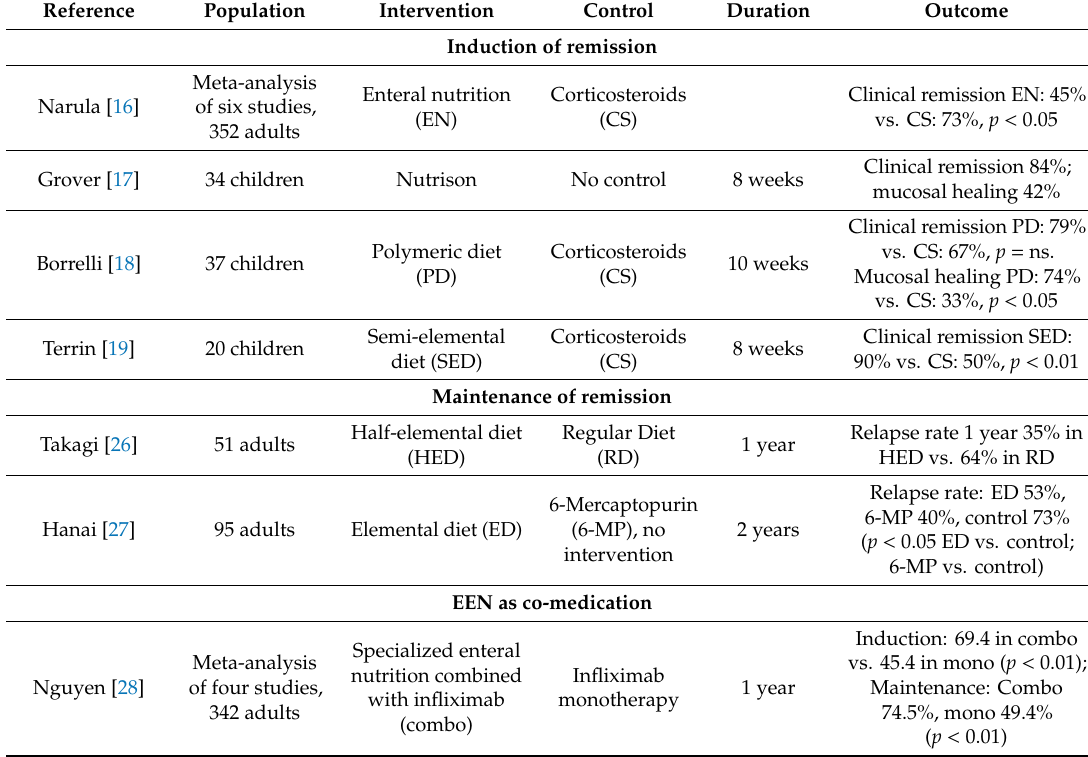
Table 1. Details of papers on EEN referenced in the